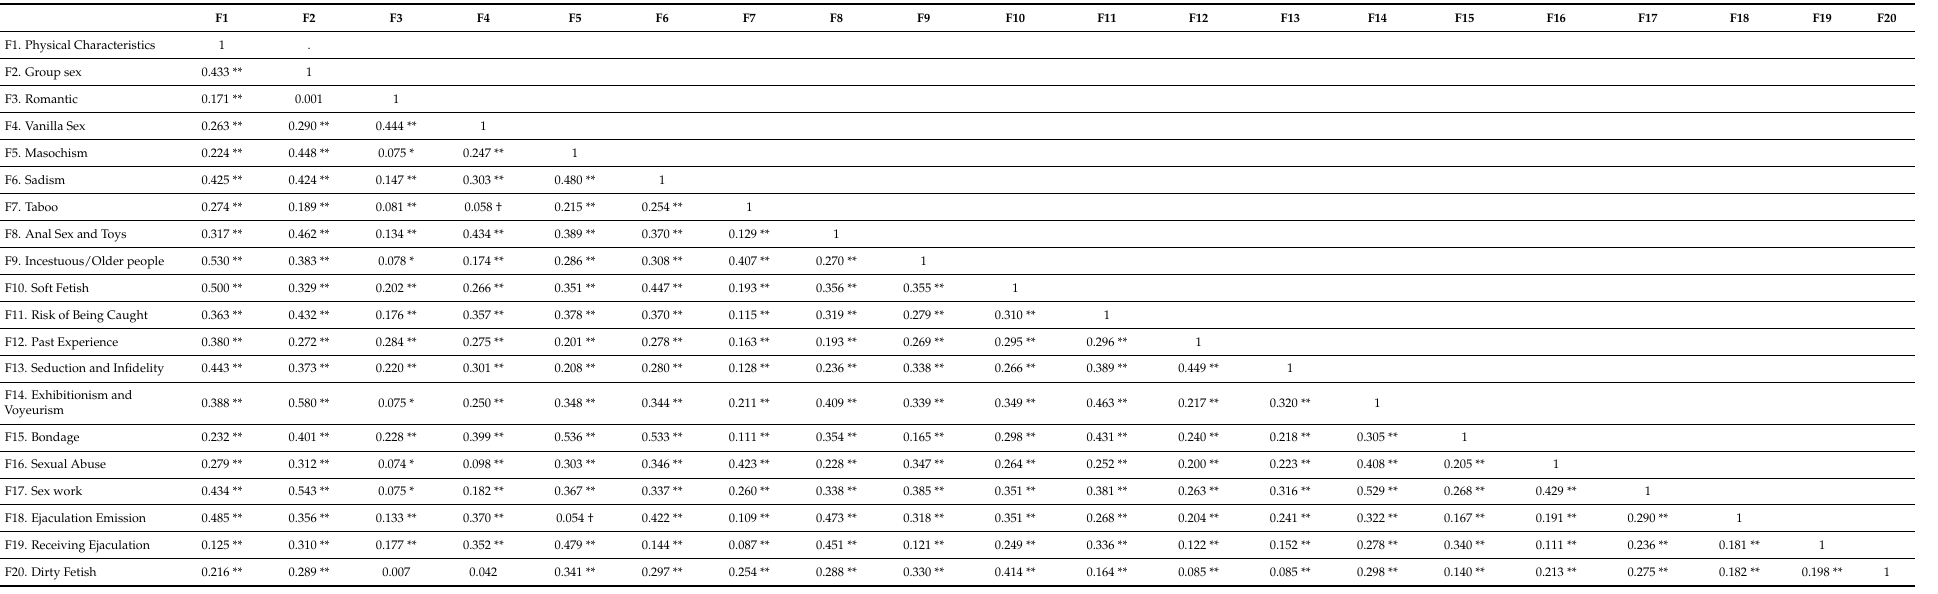
Table 2. Person’s correlation matrix among SDEF3 domains of the 20-factor